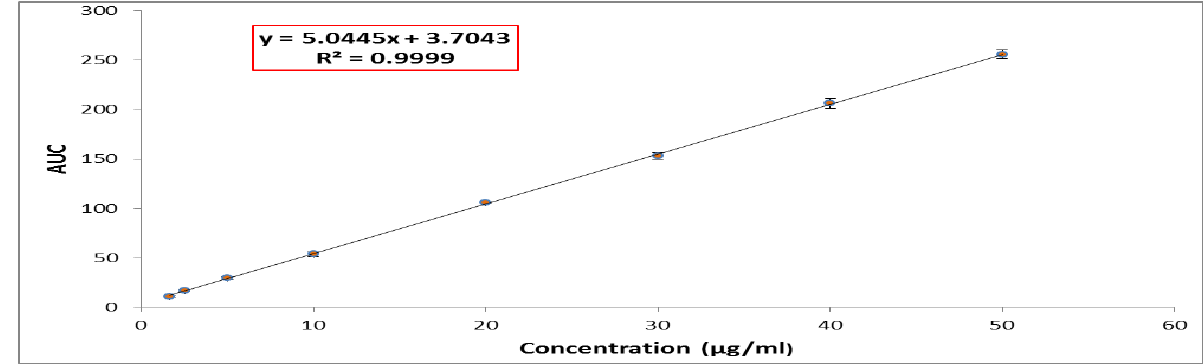
Figure 2. Calibration curve of dabigatran etexilate using HPLC, mean ± SD (n=3) Table 3. Data of inter- and intraday precision